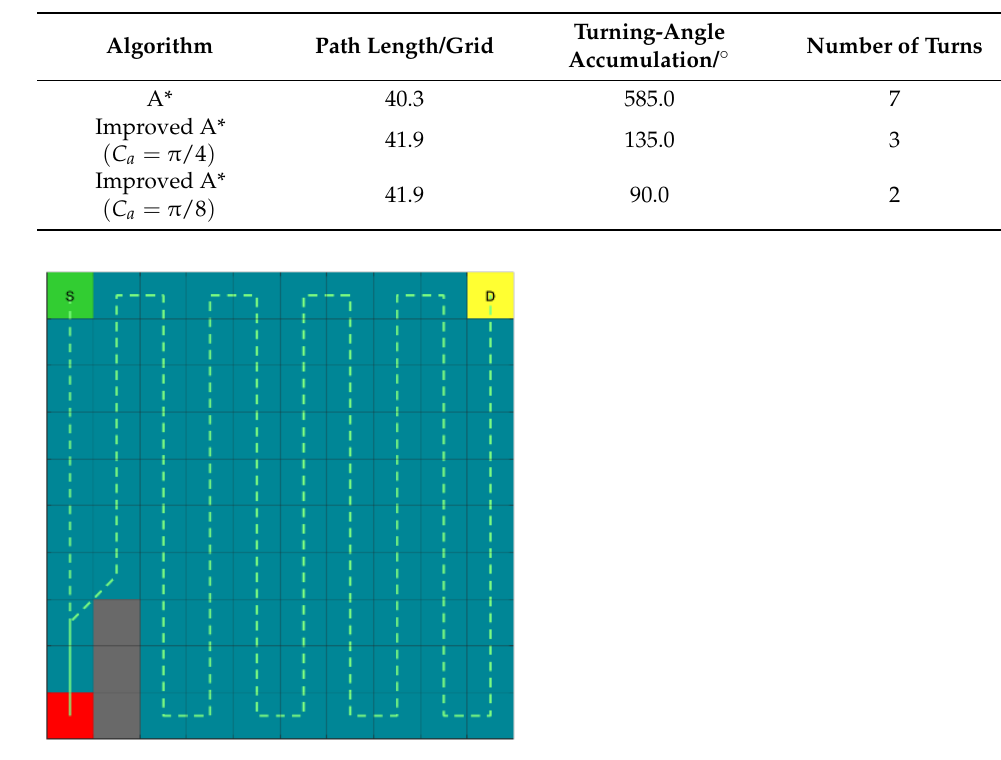
Figure 10. Generated path of the escaping the deadlock using the improved A*